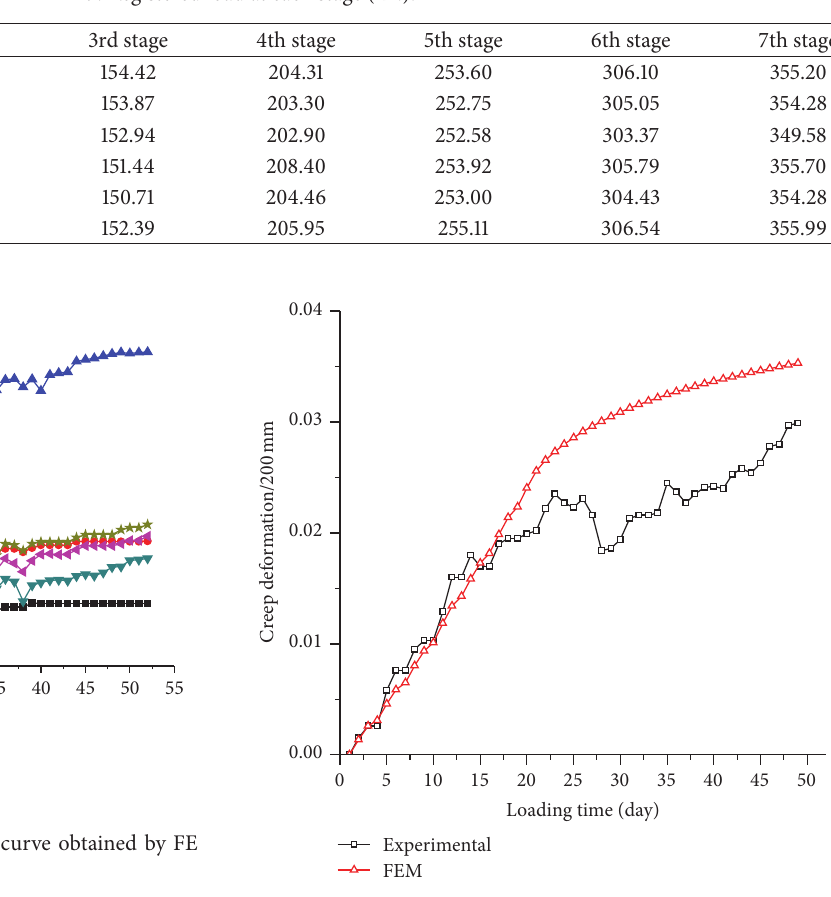
Figure11:Experimentalandnumericallongitudinalcreepdeforma- tion curves of specimen